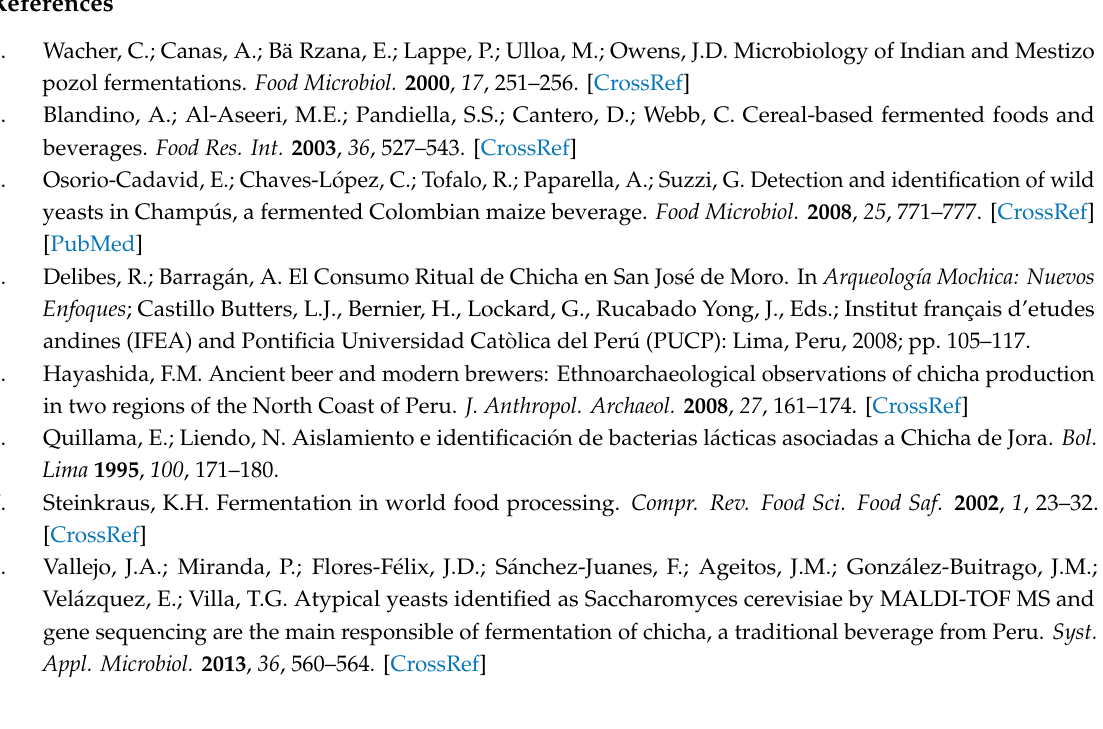
Table S1. Most abundant OTU at species level present in the 27 chicha samples. Table S2. Relative KEGG orthology groups (KO) and their abundance levels in chicha samples. Table S3. KEGG functional categories in chicha